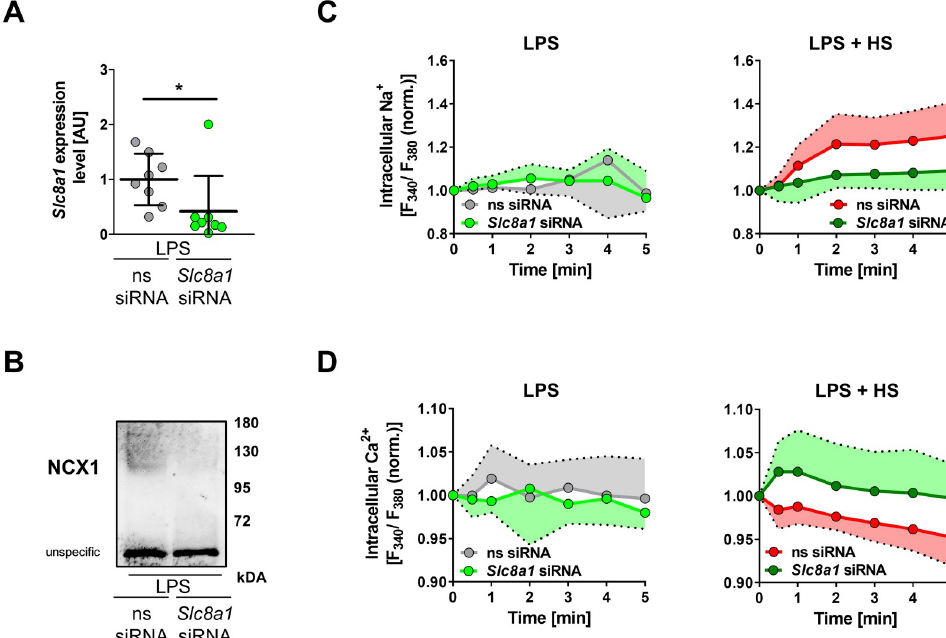
Fig 8. Slc8a1 silencing decreases Na + influx and Ca 2+ efflux. (A) Slc8a1 and (B) membranous NCX1 expression in LPS-stimulated ns or Slc8a1 -specific siRNA–treated BMDMs after 4 h (means ± SD; n = 8; Mann–Whitney test; � p < 0.05). (C) Relative [Na + ] i levels of ns siRNA and Slc8a1 siRNA–treated BMDMs exposed to LPS ± HS at t = 10 s (means ± SD; n = 5–7). (D) Relative [Ca 2+ ] i levels in ns siRNA and Slc8a1 siRNA–treated BMDMs exposed to LPS ± HS at t = 10 s (means ± SD; n = 6–11). For numerical raw data, please see S1 Data. For raw immunoblots, please see S1 Blots. BMDM, bone marrow–derived M F ; [Ca 2+ ] i , intracellular Ca 2+ in situ; HS, high salt; LPS, lipopolysaccharide; [Na + ] i , intracellular Na + in situ; ns, nonsilencing; NCX, Na + /Ca 2+ exchanger; siRNA, small interfering RNA; S lc8 , solute carrier family 8.